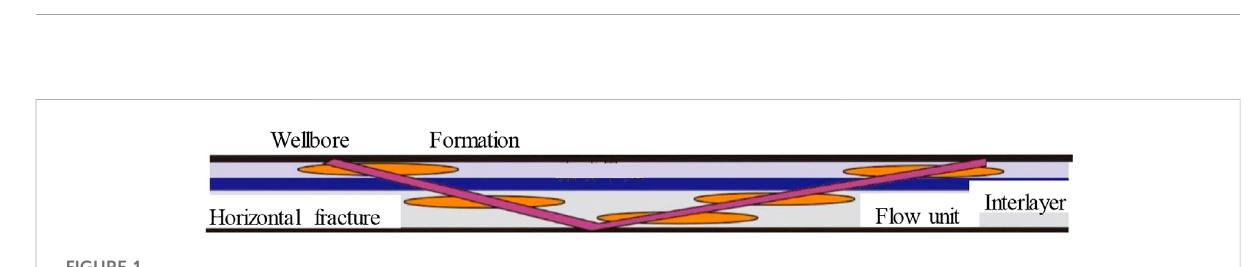
FIGURE 1 Development diagram of arch well with multiple horizontal fractures.